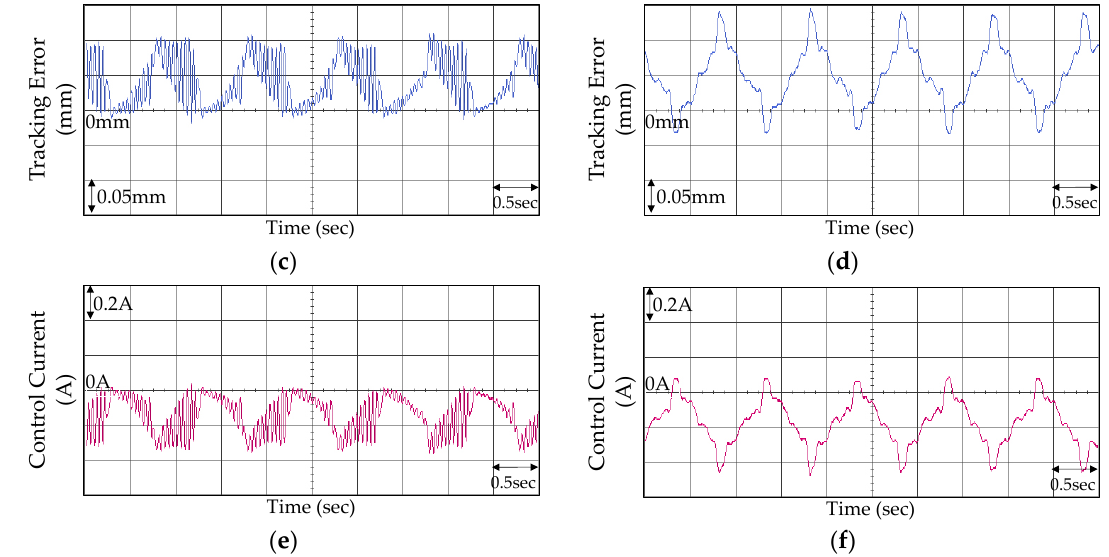
Figure 6. Experimental results of the VCM control system using the PID controller: ( a ) tracking response in Case 1; ( b ) tracking response in Case 2; ( c ) tracking error in Case 1; ( d ) tracking error in Case 2; ( e ) control current in Case 1; and ( f ) control current in Case 2.